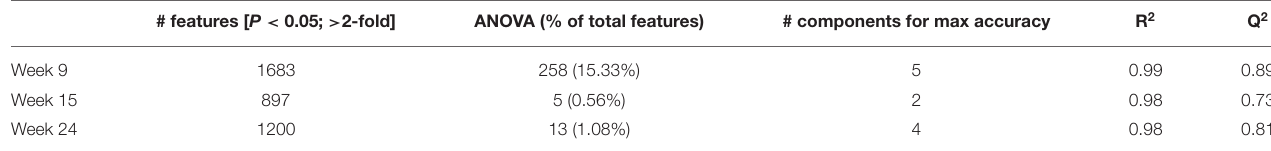
TABLE 1 | Number of mass features included in the PLS-DA models and the qualitative descriptors of the PLS-DA models in Figure 10 . # features [ P < 0.05; > 2-fold] ANOVA (% of total